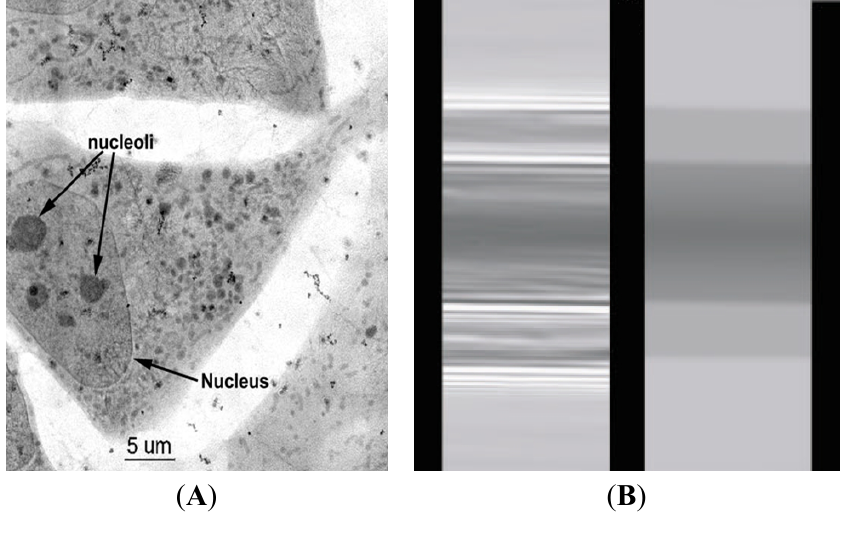
Figure 1. ( A ) Cryo X-ray microscopy of 3T3 cells [31]. ( B ) Direct comparison between the phase-contrast radiological image based on coherence of an optic fiber (on the left) and the corresponding absorption-contrast image (right) [34]. Adapted by permission from John Wiley and Sons and IOP